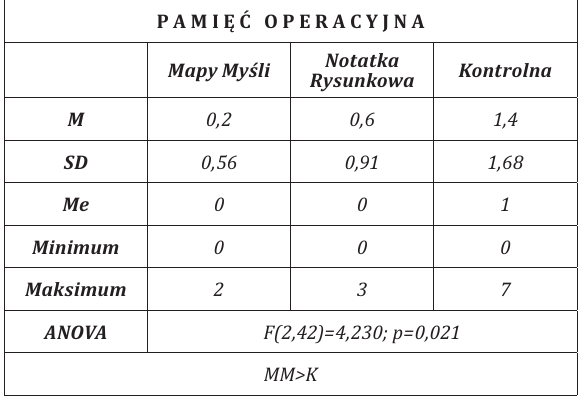
Ostatnim krokiem było sprawdzenie, czy różnice między grupami są istotne statystycznie. Analizując przedstawione rezultaty (Tab.3) można stwierdzić, Tab. 3. Porównanie wyników średnich dla zmiennej pamięć operacyjna w drugim